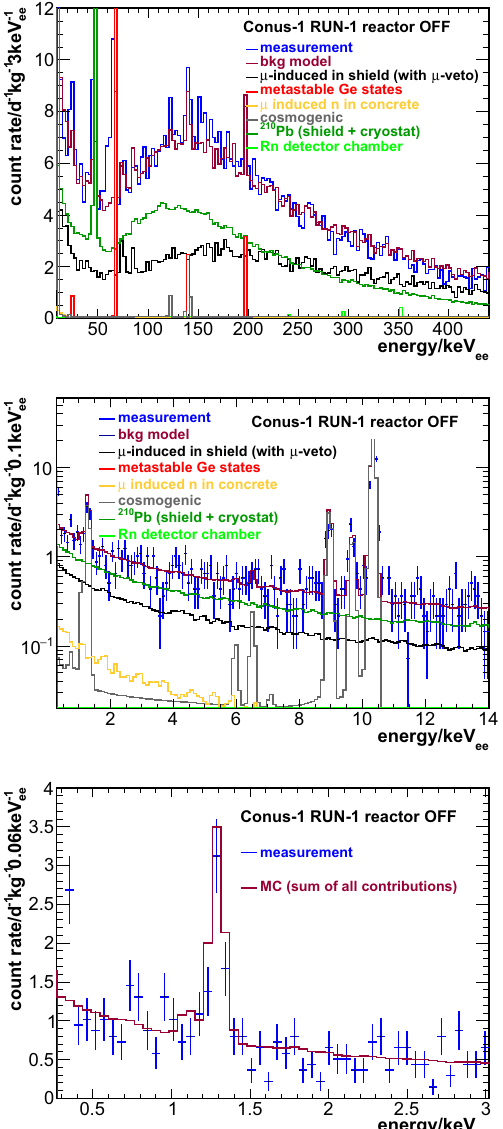
Fig. 19 ThemeasuredbackgroundspectrumofC1isdepictedtogether with the background model in the highE range and lowE range and an even smaller energy range focusing on the ROI for CE ν NS. The MC spectra from the various background sources are shown in different colors. The strong increase within the lowE range below 400eV ee is attributedtonoiseandisfittedwithanexponentialtwo-parametermodel